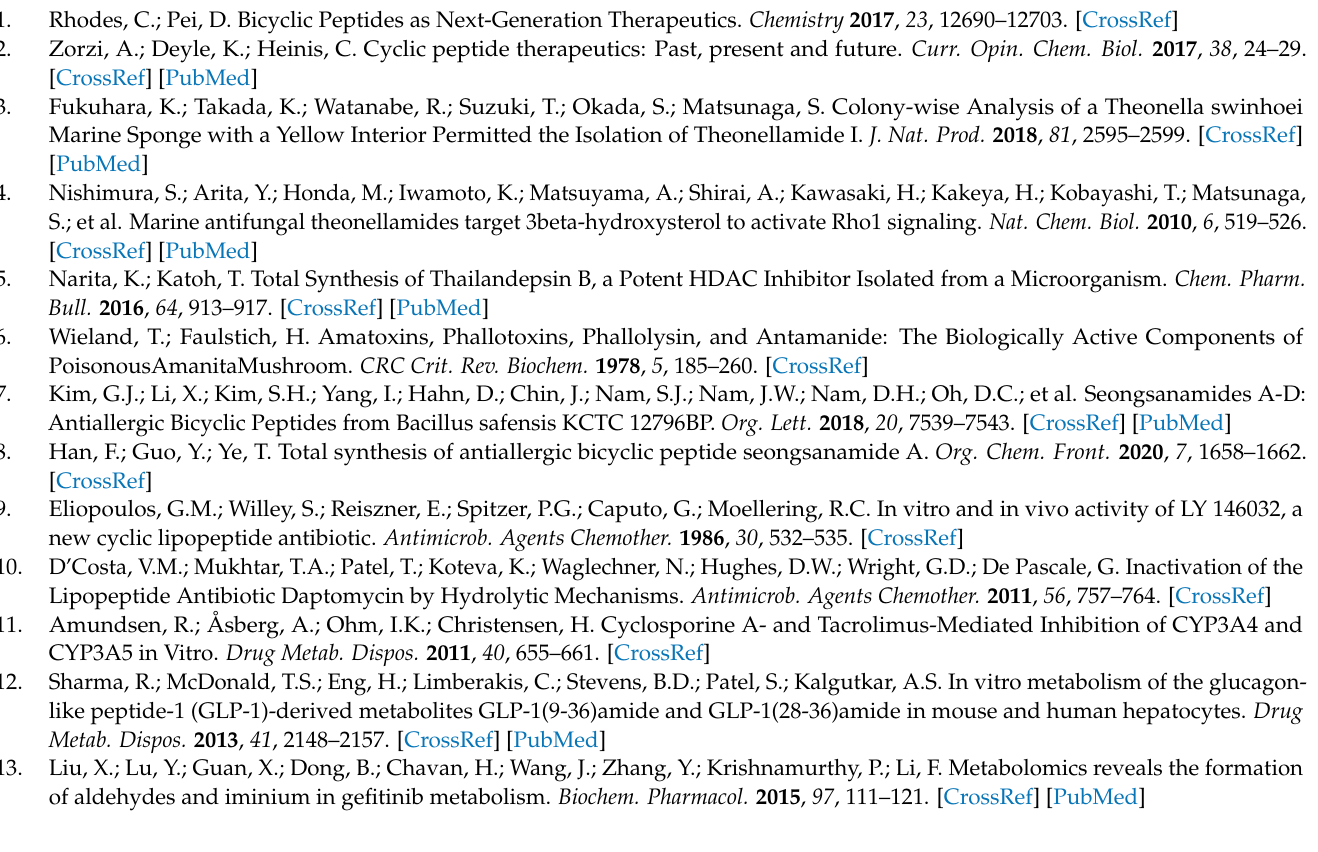
Figure S2: MS/MS fragmentation scheme for hydrolyed seongsanamide A (M1), Figure S3: MS/MS fragmentation scheme for monohydroxyseongsanamide A (M2), Figure S4: MS/MS fragmenta- tion scheme for dihydroxyseongsanamide A (M3), Figure S5: MS/MS fragmentation scheme for trihydroxyseongsanamide A